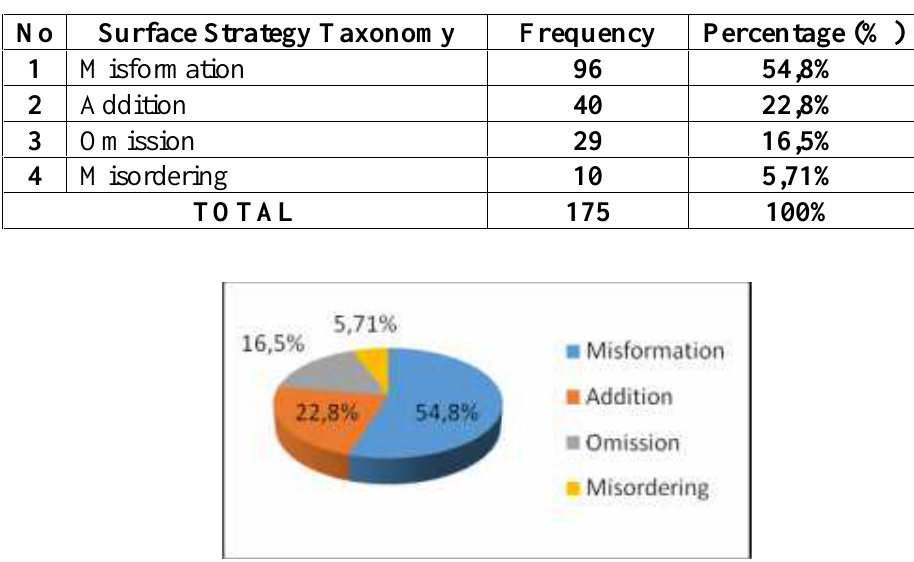
Figure 1: The Distribution of Students’ Errors on Surface Strategy